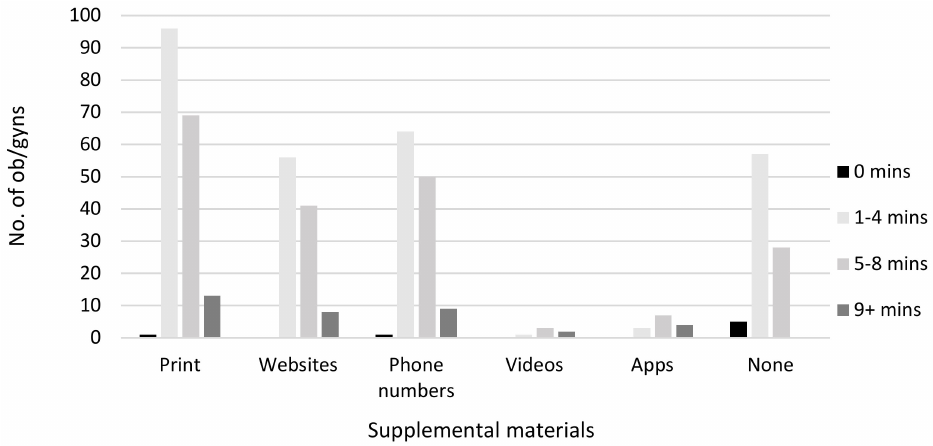
Figure 1. Obstetrician and gynecologist (ob / gyn) use of supplemental materials by minutes spent discussing SHS risks / cessation with patients.